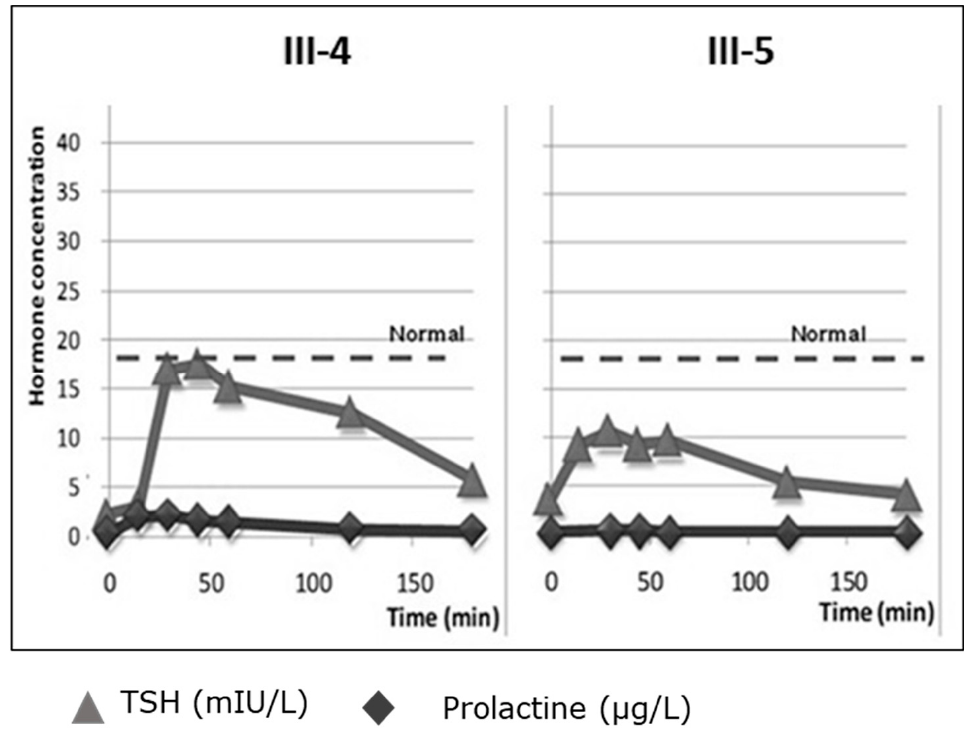
Figure 3. TRH stimulation tests results of patient III-4 and III5 with the p.C947R variant. Y -axis shows TSH (mIU/L) (in grey) and prolactine (ug/L) hormone concentrations (in black).